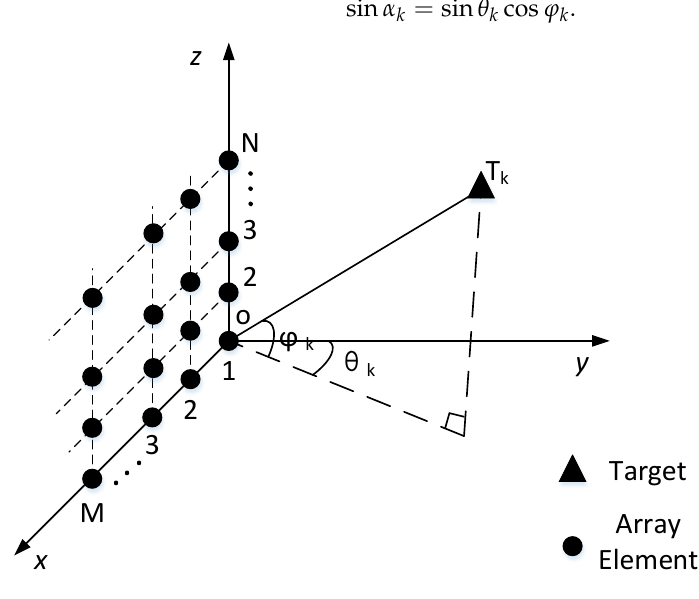
Figure 1. Geometry of rectangular